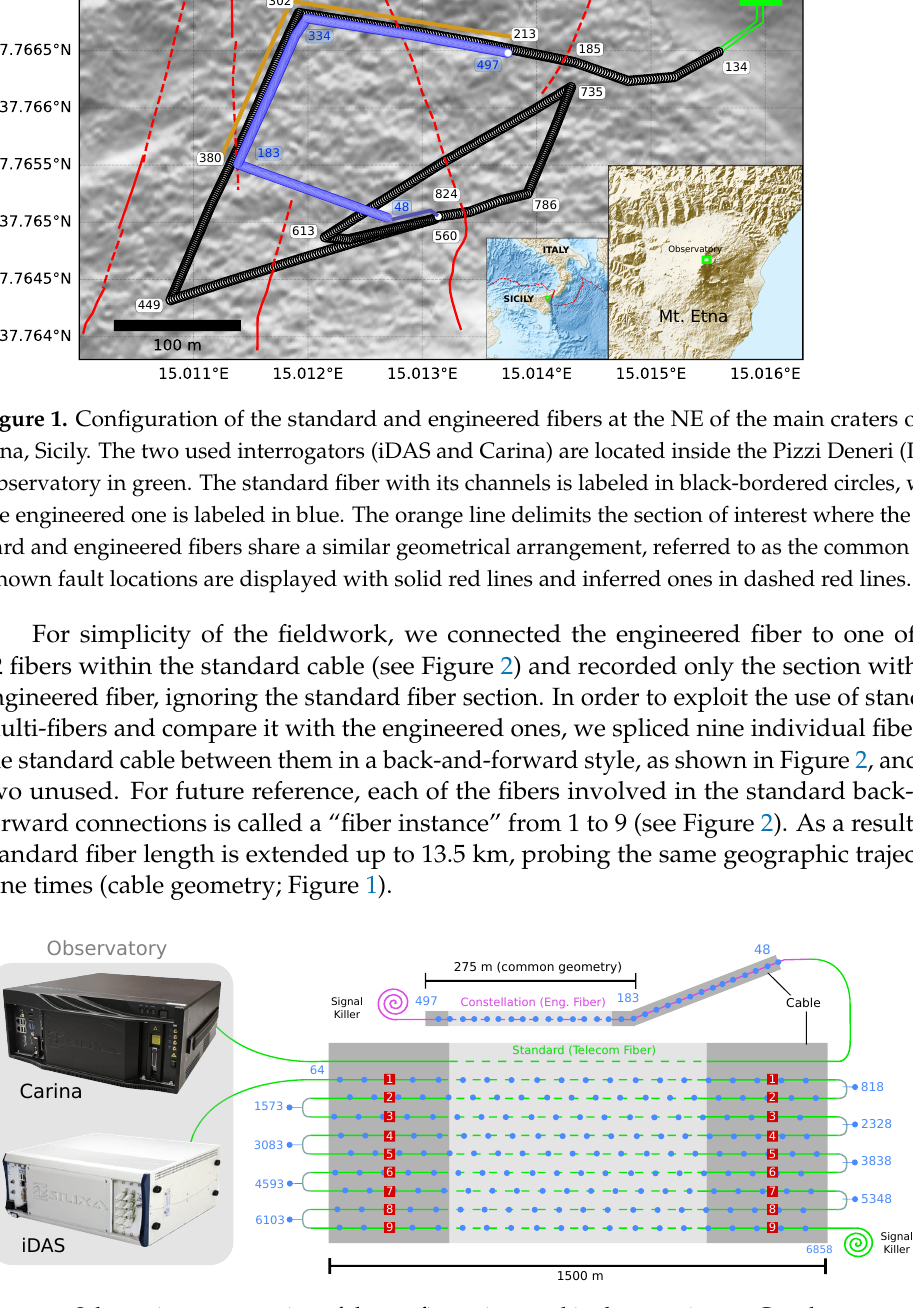
Figure 2. Schematic representation of the configuration used in the experiment. Grey boxes represent the cable. The green and purple lines represent the standard and engineered fibers, respectively. Individual channels are indicated by blue dots and labels. Red boxes with numbers indicate the fiber instance within the standard cable once the individual standard fibers were spliced in a back- and-forward way. Signal killers are optical attenuators made of tight coils in order to avoid high reflections from the end of the fibers. The two interrogators (iDAS and Carina) are located in the PDN